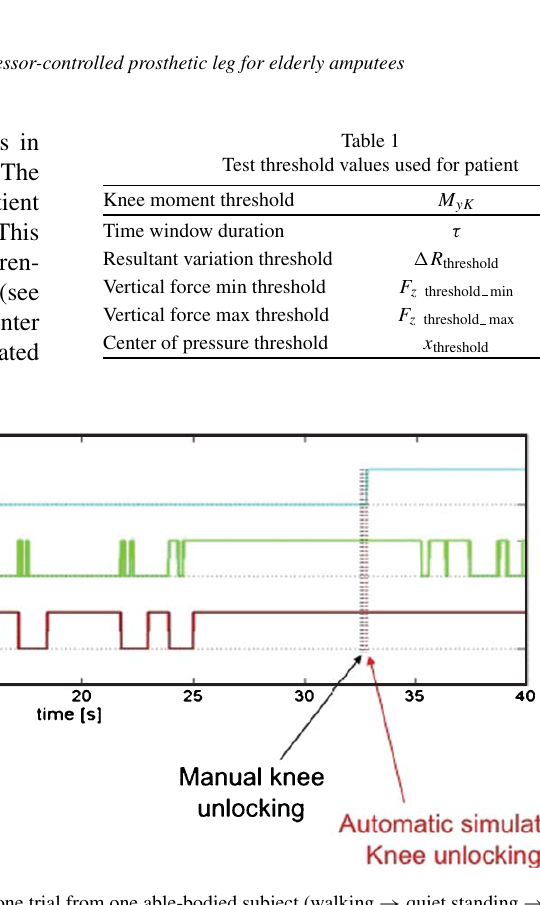
Fig. 10. Performance of the detection algorithm tested on one trial from one able-bodied subject (walking → quiet standing → sitting).